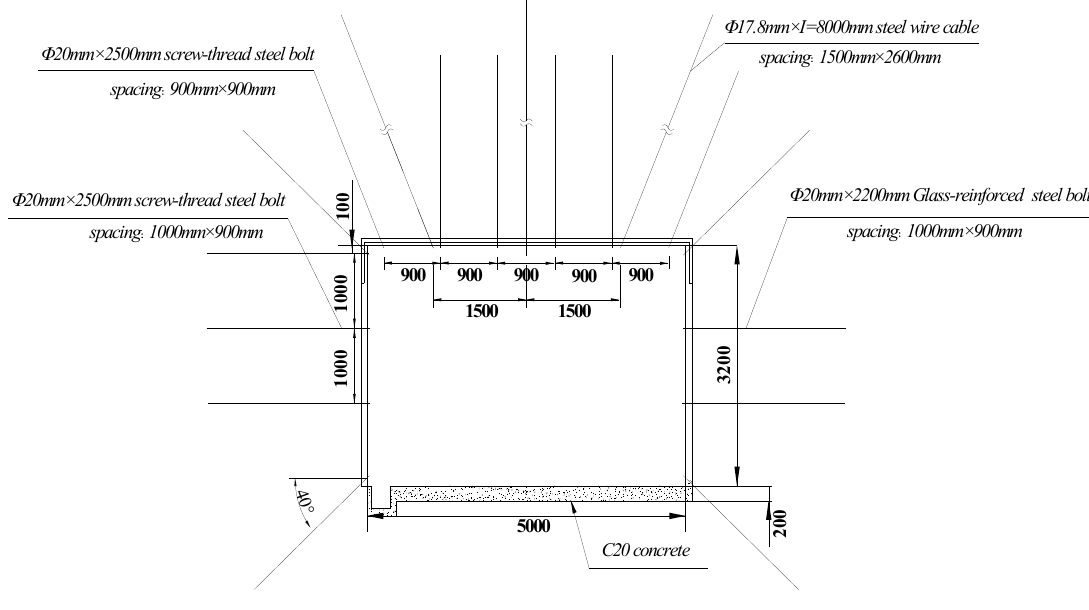
Figure 1. Design of the original roadway support.